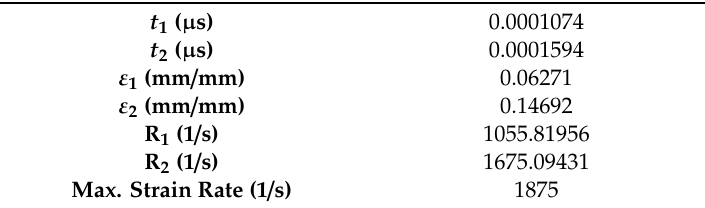
Figure 16. Time–strain curve obtained from SHPB test of adhesive 1 (Phase 2). Table 5. Data obtained from time–strain curve of adhesive 1 (Phase 2).